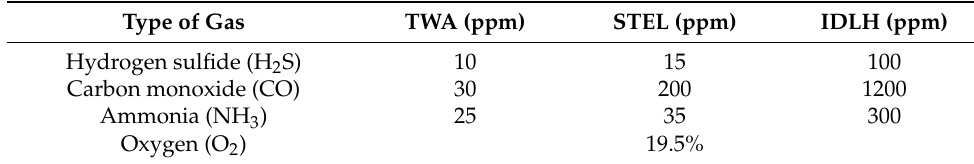
Table 1. Threshold limits of